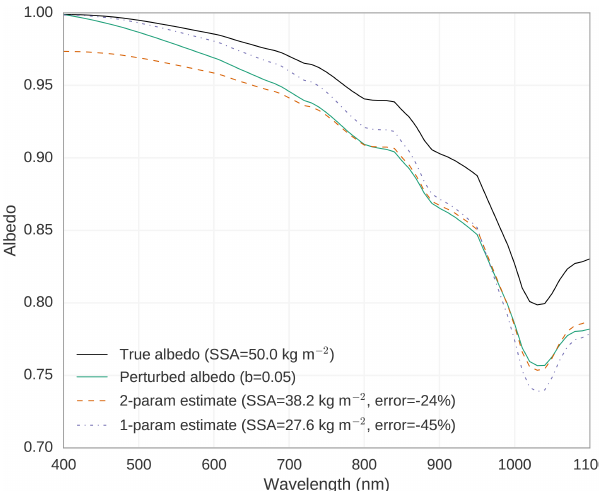
Figure 3. Simulations of albedo spectrum for SZA = 60 ◦ . A per- fect albedo spectrum for an homogeneous snowpack with SSA of 50m 2 kg − 1 (black) is perturbed by a factor linearly decreasing from 1 at 400nm to 1 − b at 1100nm with b = 5% (green) and used as an observation to estimate SSA with the one-parameter (violet thin dash) and two-parameter models (orange, long dash). Estimated val- ues are shown in the legend along with the relative error.